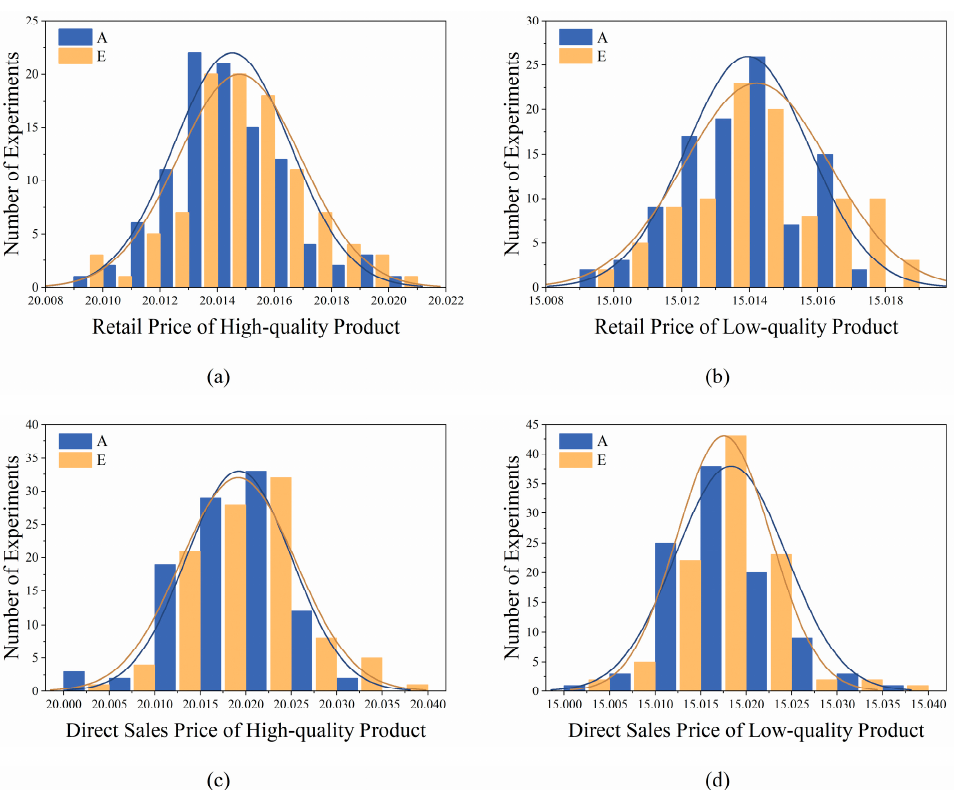
Figure 15. Prices in A and E of: ( a ) high-quality product in retail channel; ( b ) low-quality product in retail channel; ( c ) high-quality product in direct sales channel; ( d ) low-quality product in direct sales channel. ( t = 100).